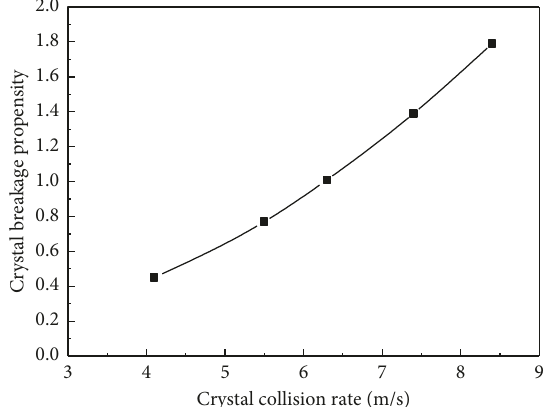
Figure 13: Relationship between collision rate and crystal breakage